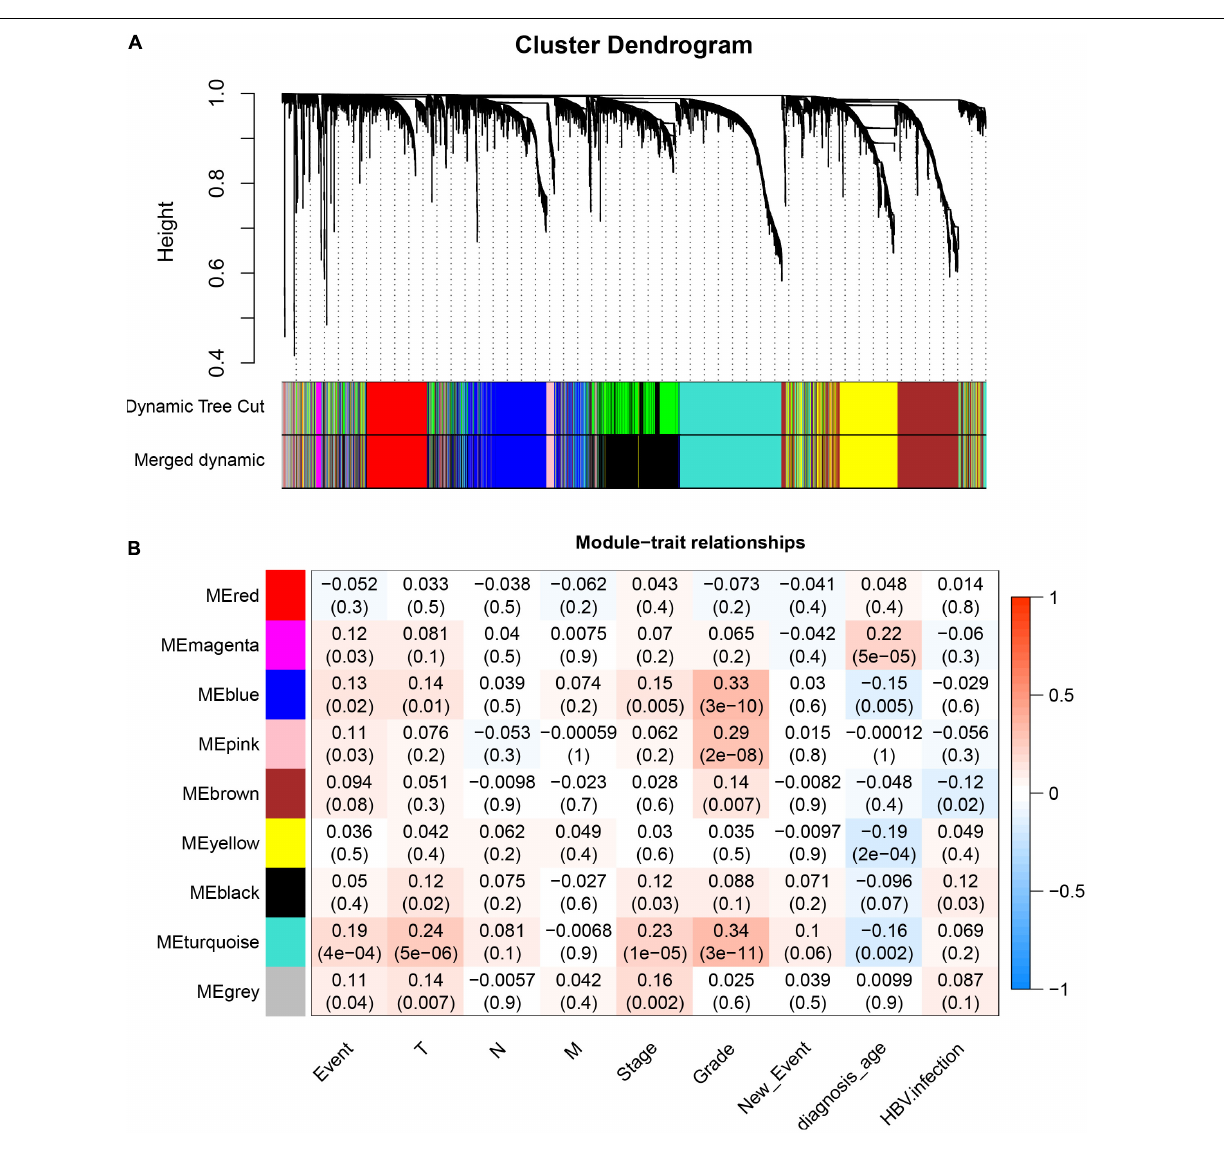
basis of log-rank test analysis ( Supplementary Figures 1–5 ).